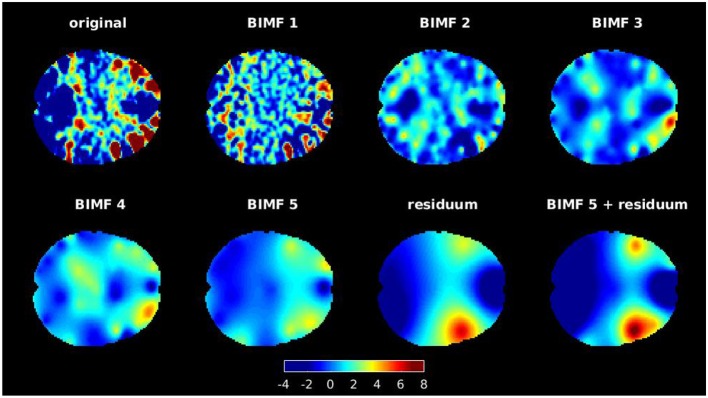
An example of decomposing a brain slice with GiT-BEEMD in the transverse anatomical plane. The slice was decomposed into five intrinsic modes and one residuum. Note that BIMF 1 contains the highest spatial frequencies, which gradually decrease for the other extracted BIMFs. Also, the combination of the fifth BIMF and residuum is illustrated, as this combination is used for further evaluations. A mask was applied after the decomposition to set all intensity values that were located outside of the scanned brain to zero.